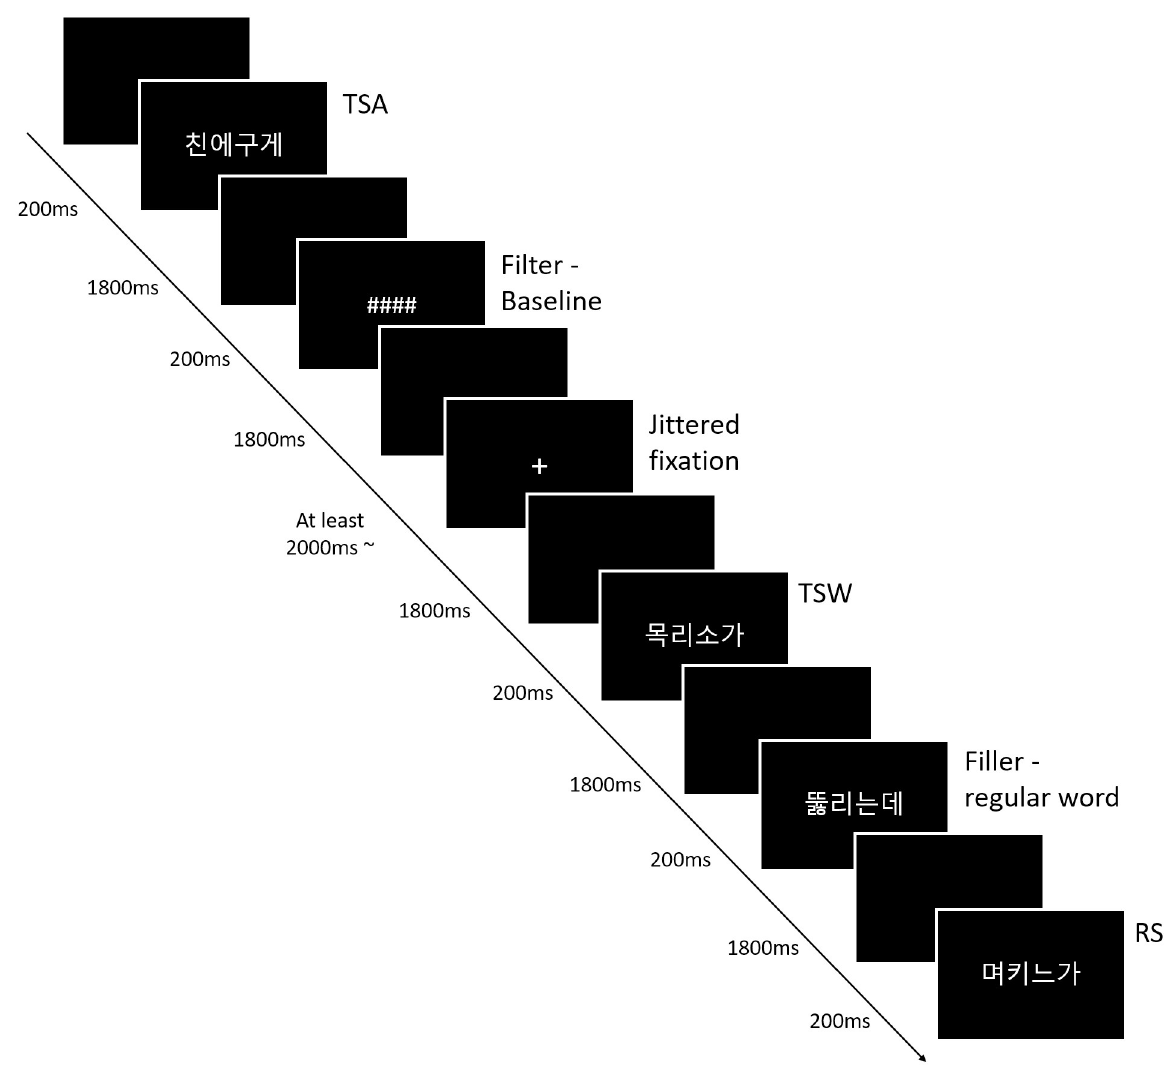
Fig 1. Experimental